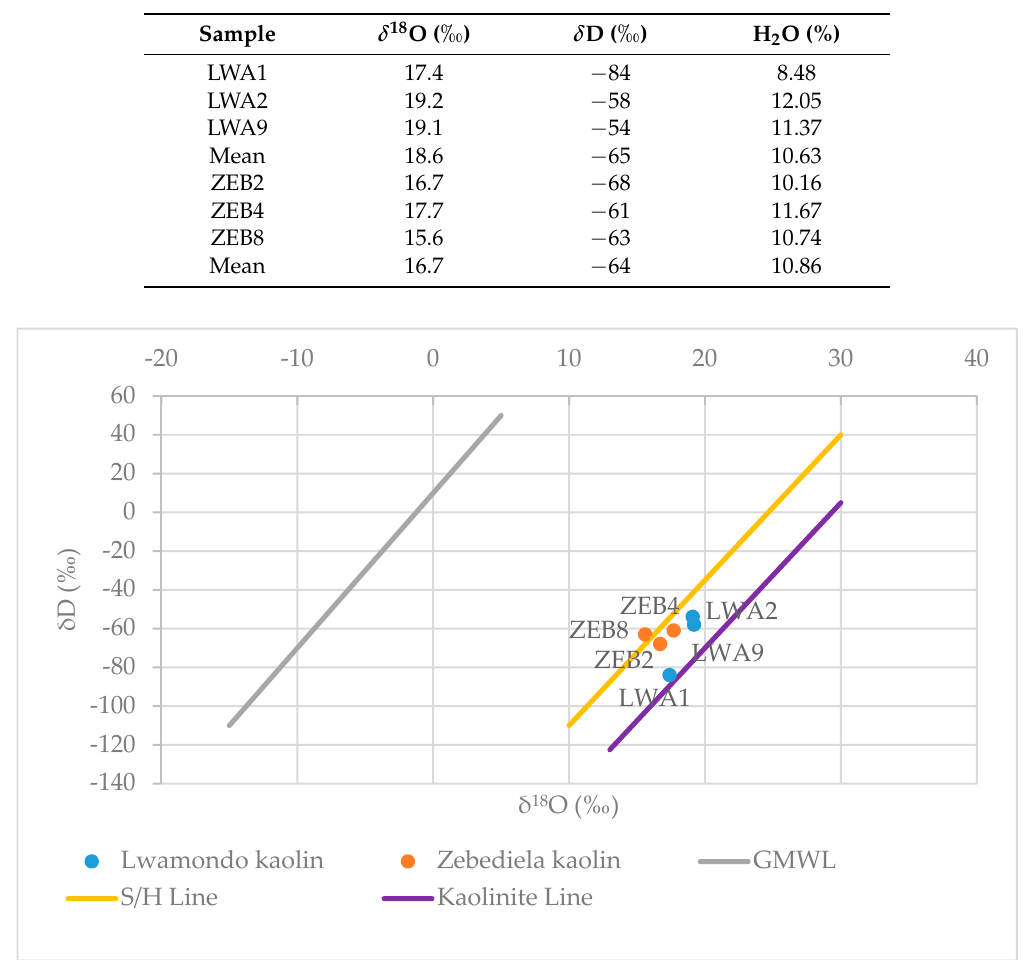
Figure 7. δ 18 O versus δ D plot of clay fractions of the Lwamondo and Zebediela kaolins. The global meteoric water line (GMWL), the supergene – hypogene line (S/H line) and the kaolinite line are plotted for reference.